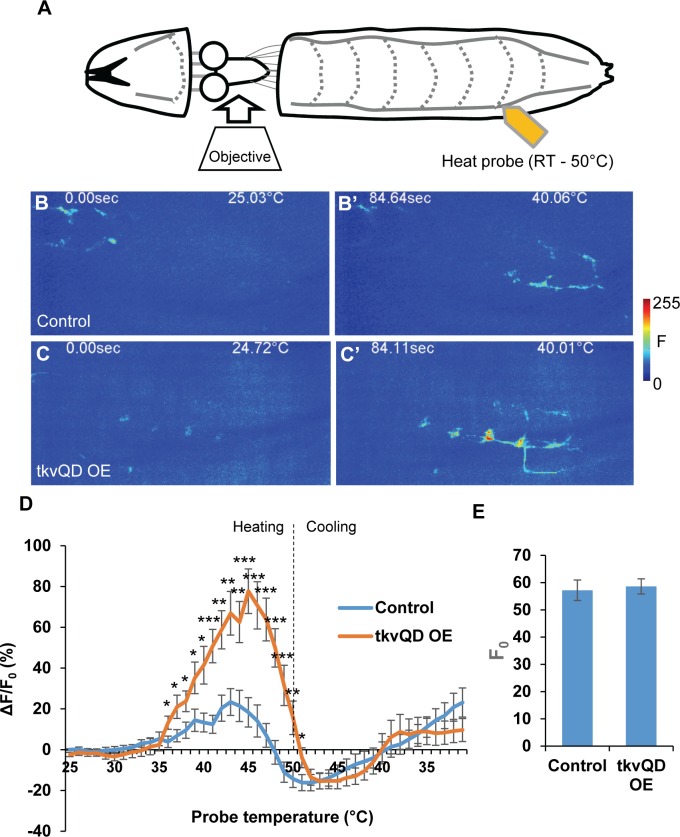
Elevated BMP signaling increases Ca2+ responses in nociceptor axon terminals.(A) A cartoon showing the Ca2+ imaging preparation to monitor GCaMP6m signals from nociceptor terminals during heat ramp stimuli. (B and B’) Representative images showing thermal activation of nociceptors in control animals during calcium imaging (ppk-GAL4 UAS-GCaMP6m x w1118). In comparison to the initial frame (B), the GCaMP6m signal monitored at nociceptor axon termini was increased when the probe temperature reached 40°C (B’). (C and C’) Images showing a representative result of animals with nociceptor-specific up-regulation of BMP signaling (tkvQD OE, ppk-GAL4 UAS-GCaMP6m x UAS-tkvQD). Compared to the baseline (C), increase of GCaMP fluorescent intensity was observed when the probe temperature reached 40°C (C’). (D) Average percent increase of GCaMP6m fluorescent intensity relative to baseline (ΔF/F0) during heat ramp stimulations. ΔF/F0 is plotted to binned probe temperature (interval = 1 °C). In controls, GCaMP6m fluorescence in nociceptors began increasing when the probe temperature reached 37 °C, peaked at 43°C, and returned to baseline at 47 °C. In comparison to controls, nociceptors of tkvQD OE animals showed a highly exaggerated fluorescent increase of GCaMP through 36°C to 50°C. n = 17 and 19 for controls and tkvQD OE, respectively. * p < 0.05, ** p < 0.01, *** p < 0.001 (Mann-Whitney’s U-test). (E) Basal GCaMP6m signals (F0) did not differ significantly between controls and tkvQD OE (n = 17 and 19). p > 0.5 (Mann-Whitney’s U-test). All error bars represent standard error.